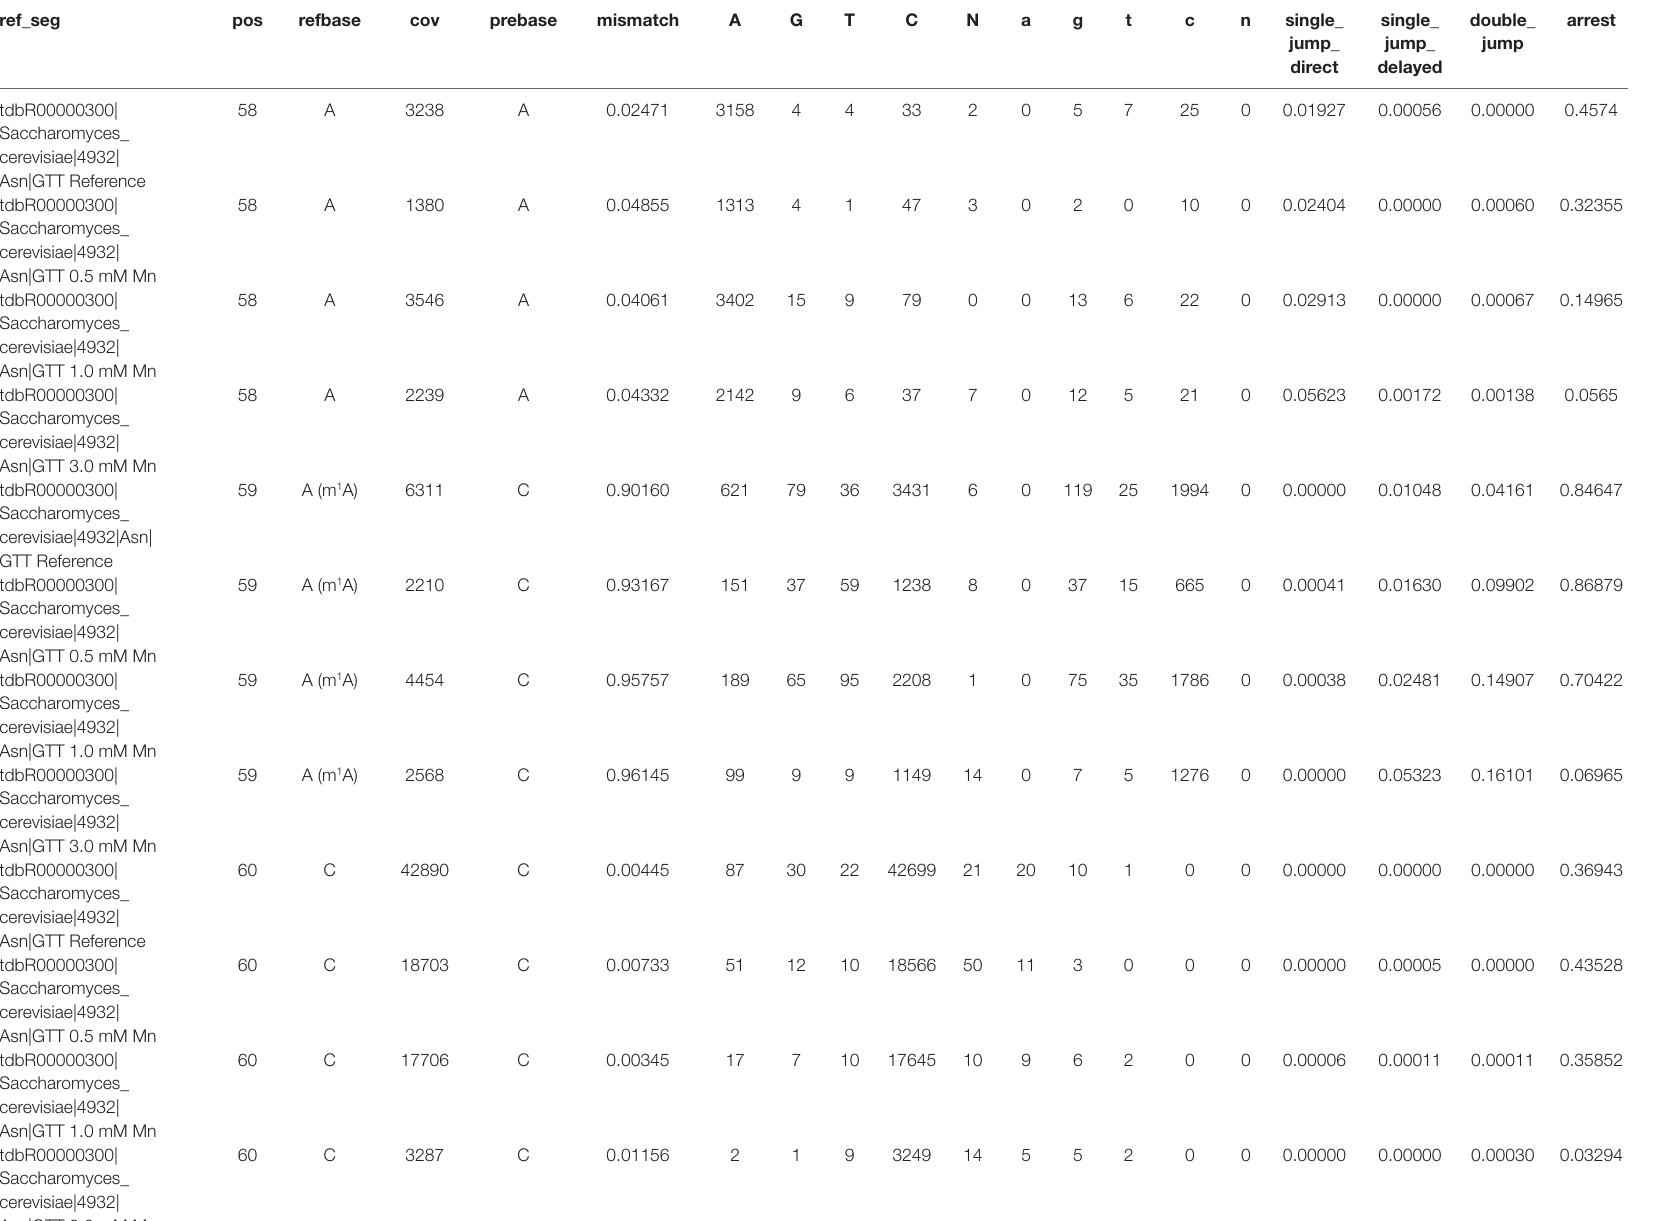
TABLE 2 | Extracted Profile data for yeast tRNA Asn (GTT) after library preparation with 4 different buffer mixtures for the reverse transcription step. Shown are data for positions 58, 59 (m 1 A), and